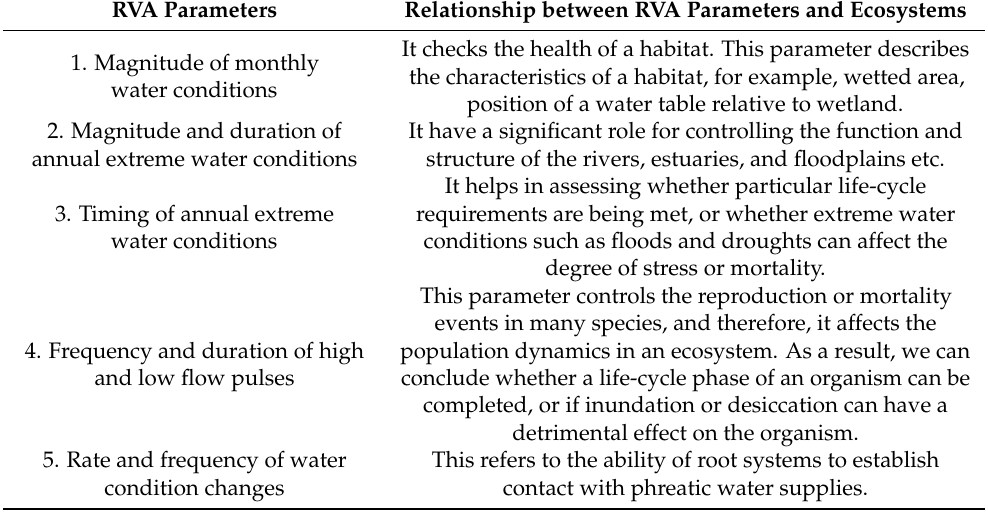
Table 2. The relationship between RVA parameters and ecosystems [67].